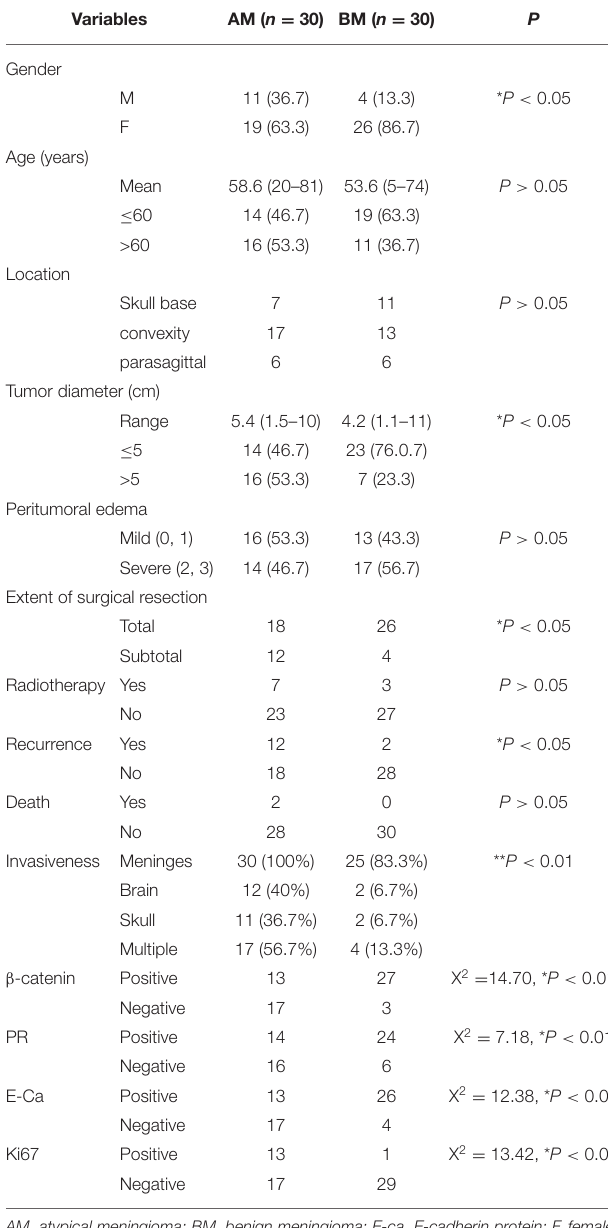
TABLE 1 | Clinicopathological characteristics of AM patients and BM